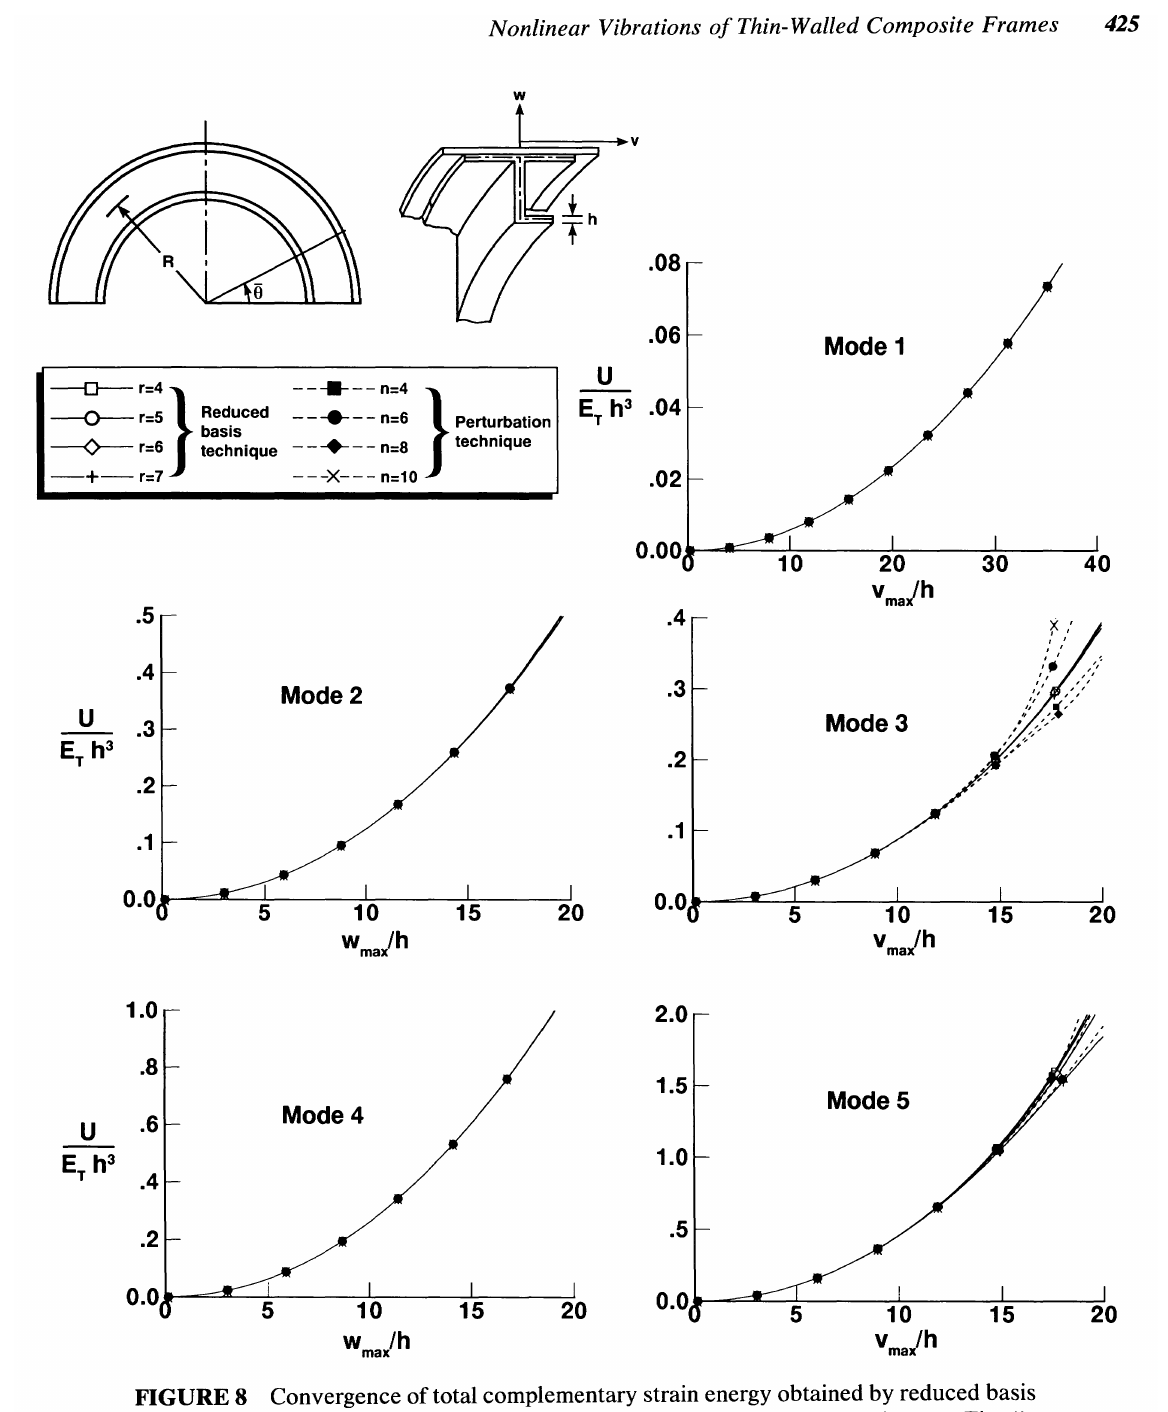
FIGURE 8 Convergence of total complementary strain energy obtained by reduced basis and perturbation techniques. Thin-walled composite frame with J cross section (see Fig.